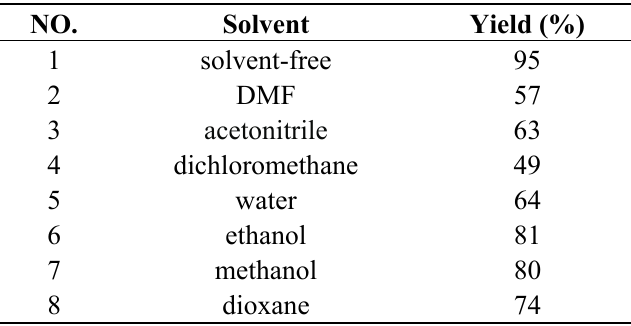
Table 3. FeF catalyzed synthesis of 7-hydroxy-4-methyl-chromen-2-one ( 4 ) under various 3 solvent and solvent-free